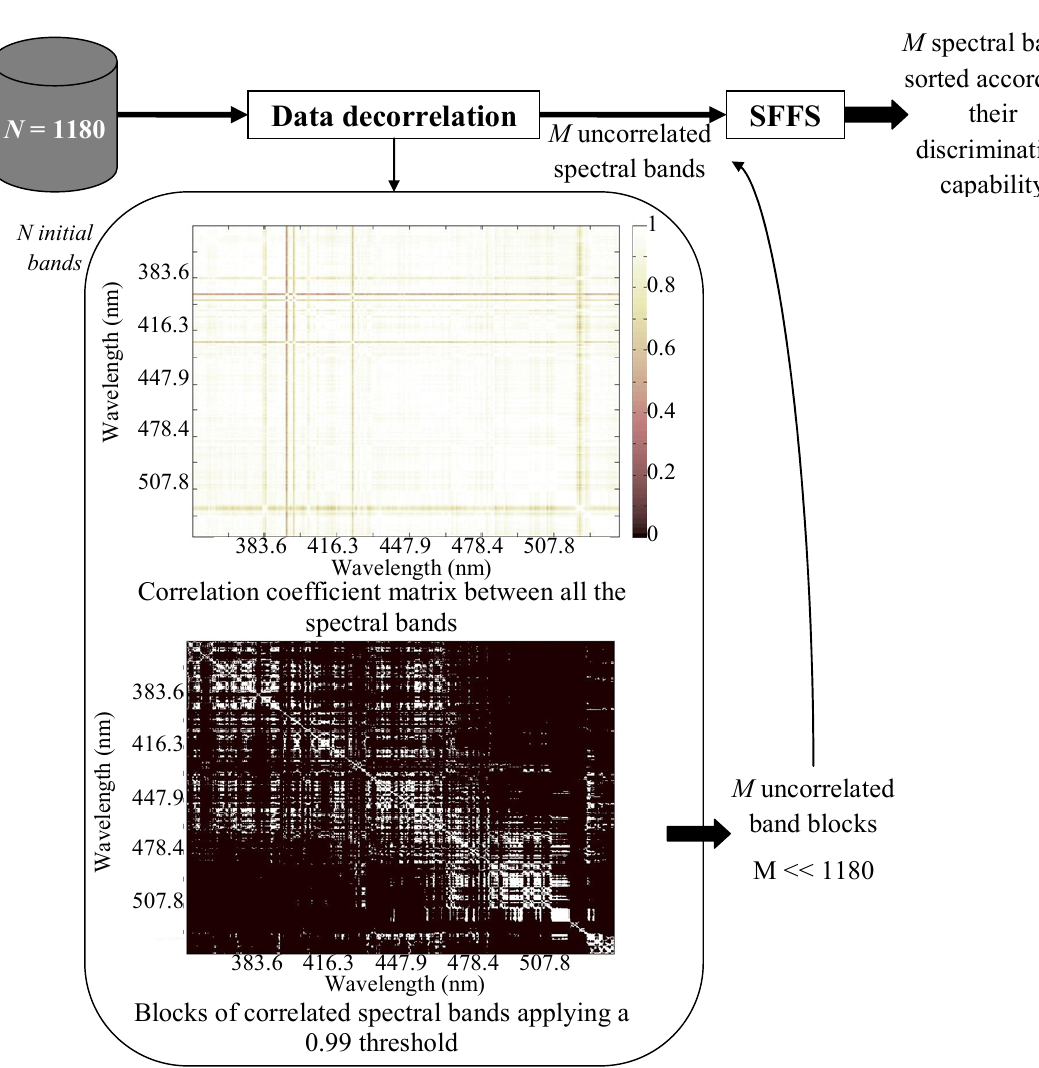
Figure 3. Block diagram of the spectral band selection and sorting